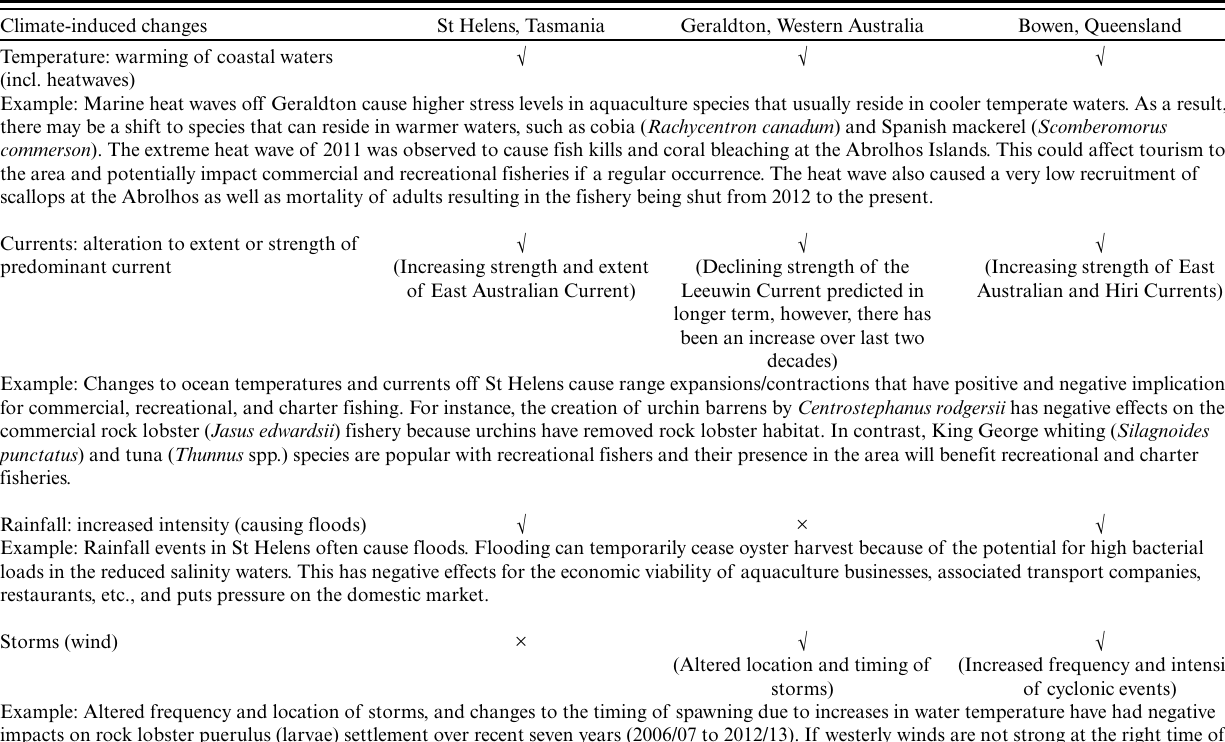
Table 2 . Perceptions of climate and main nonclimate changes in the case study communities, as identified by expert opinion and consultation with local community members. Case study examples of changes and impacts are